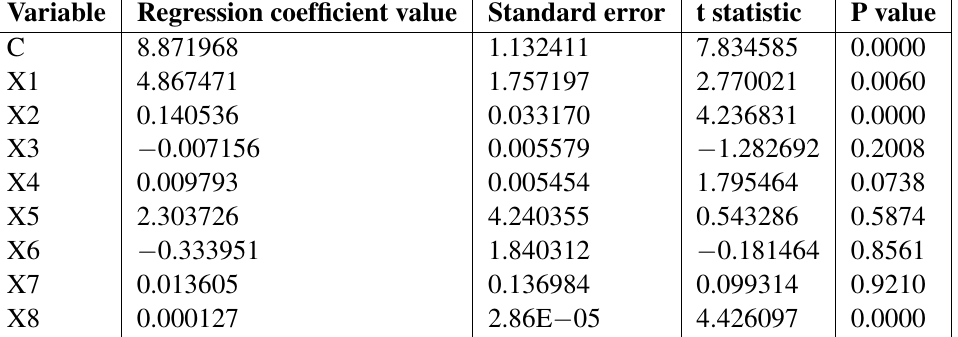
Table 4 Fixed influence variable intercept model estimation